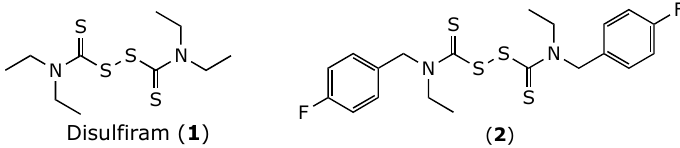
Figure 1. Chemical structure of disulfiram ( 1 ) and its analogue ( 2 ).